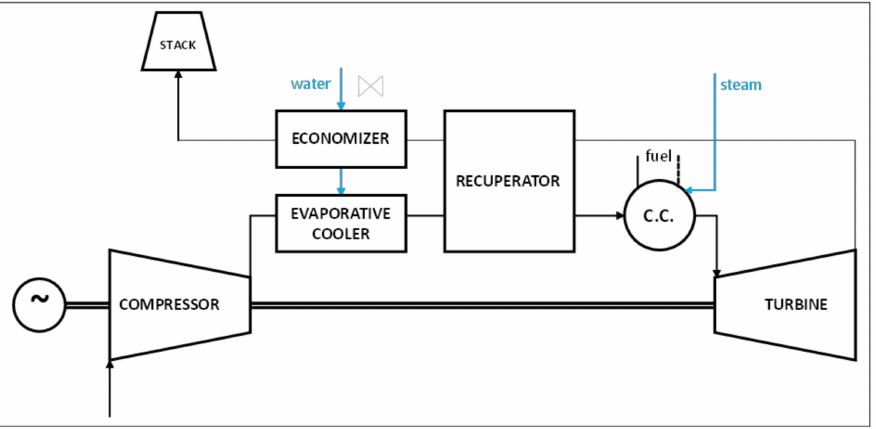
Figure 5. H-STIG layout [34].